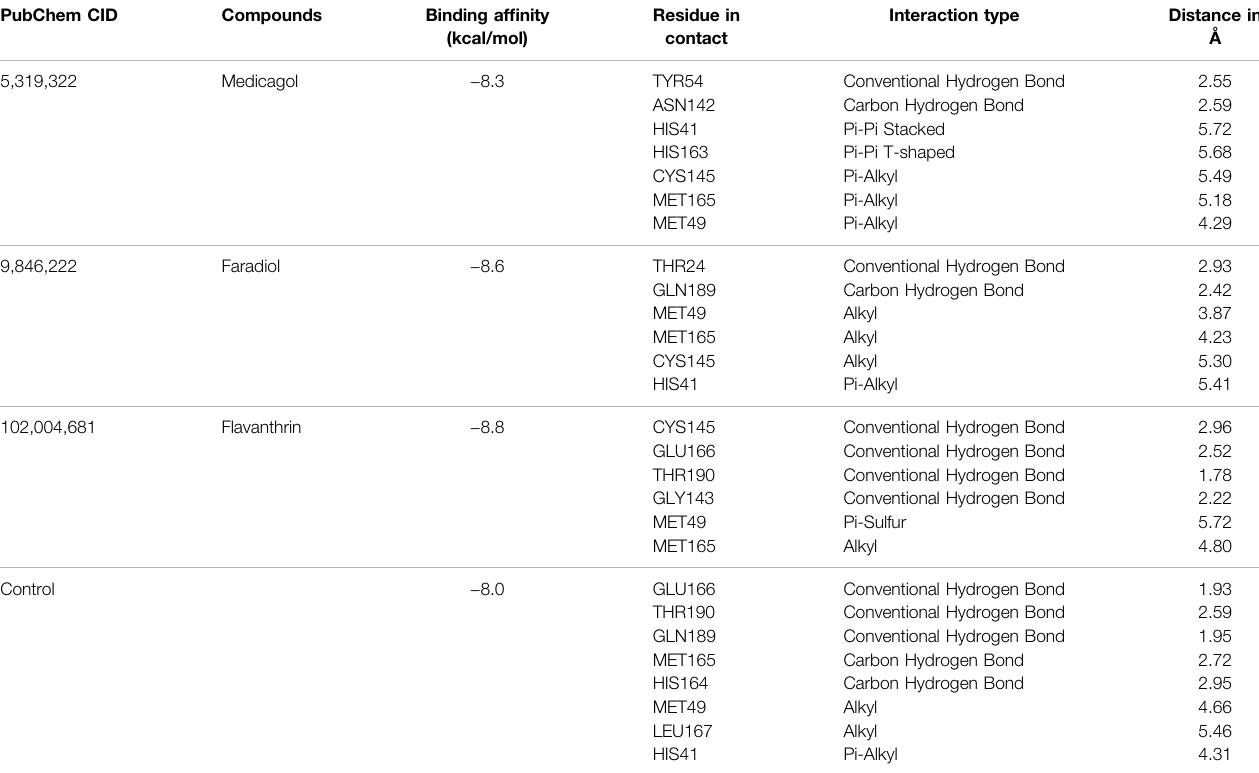
TABLE 1 | Non-bond interactions between SARS-CoV-2 main protease and the top three compounds. PubChem CID Compounds Binding af fi nity